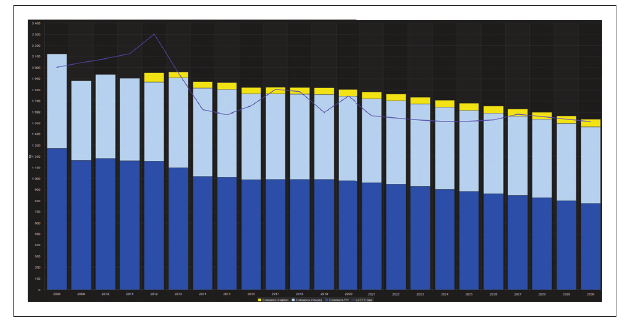
Source : Figure generated in Thomson Reuters Eikon 2016 FIGURE 4: Composite bar graph showing the past, current and forecasted emissions by sector (industry in light blue vs aviation in yellow) in the European Union Emissions Trading Scheme baseline scenario. Alongside, a line graph showing the European Union Emissions Trading Scheme emissions cap in MtCO e between 2008 and 2